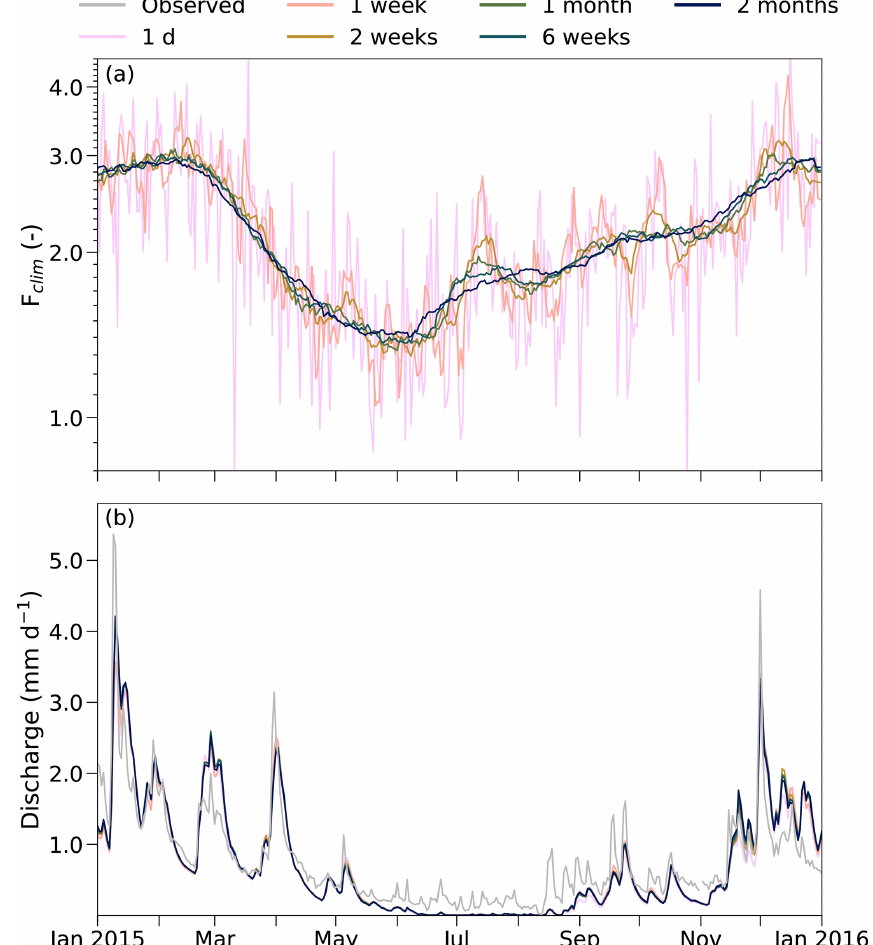
Figure 8. Sensitivity of the CARROTS factor derivation to the moving window size. (a) The adjustment factors for the Aa catchment for six different moving window sizes. The moving window size of 31d was used in the methodology of this study. (b) The effect of the six moving window sizes in (a) on the simulated discharges for the Aa. Similar to Fig. 7, the CARROTS factors were derived, and discharge was simulated for the full period (2009–2018), but only 2015 is shown here. The grey line indicates the observed